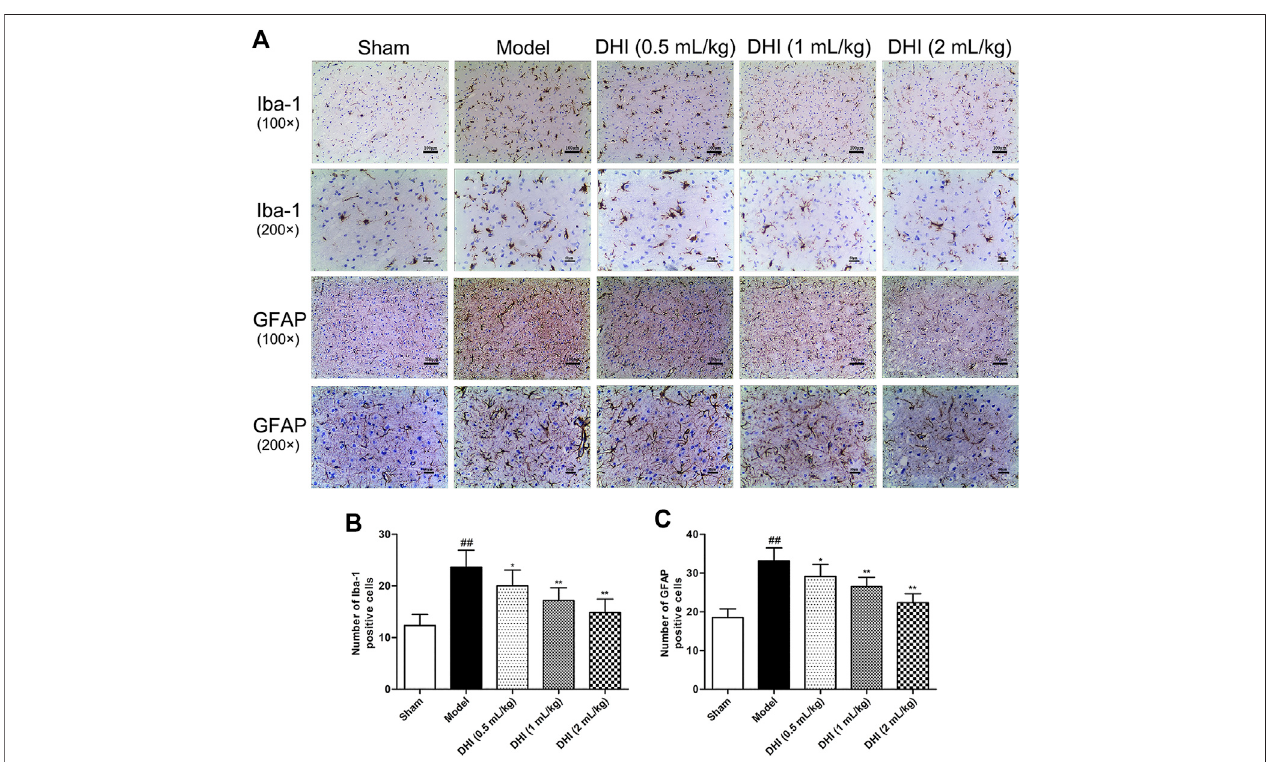
FIGURE 7 | Effects of DHI on the protein expressions of Iba-1 and GFAP at 24 h after CIRI in rats. (A) Representative immunohistochemical images of Iba-1 and GFAPinthepenumbraofischemicipsilateralparietalcortexafterCIRIinratsat100 × and200 × magni fi cation. (B,C) ImmunohistochemicalanalysisofIba-1andGFAPin the penumbra of ischemic ipsilateral parietal cortex after CIRI in rats. Mean ± SD ( n (cid:2) 6). Asterisks denote the signi fi cant levels: ## P < 0.01 vs. sham group and * P < 0.05 and ** P < 0.01 vs. model group.